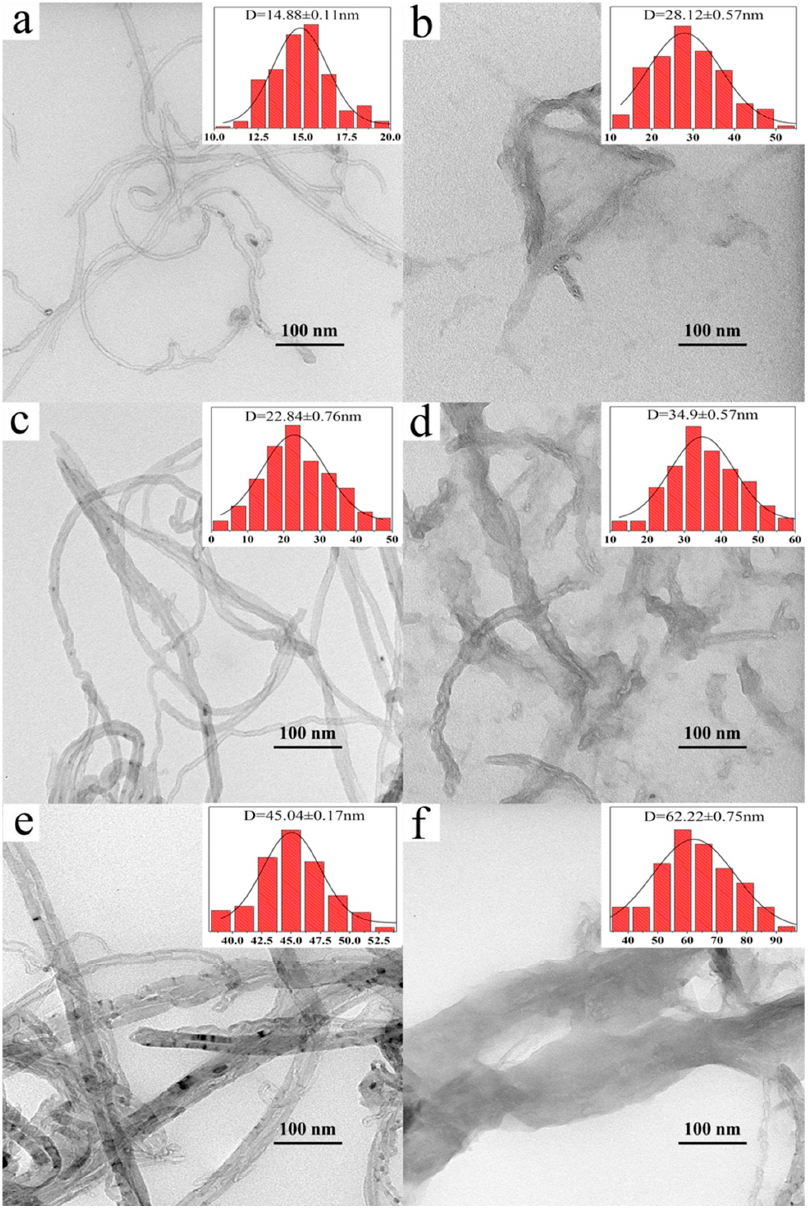
Figure 2. TEM images and the distributions of CNT-15 ( a ), uCNT-15 ( b ), CNT-23 ( c ), uCNT-23 ( d ), CNT-45 ( e ), and uCNT-45 ( f ).